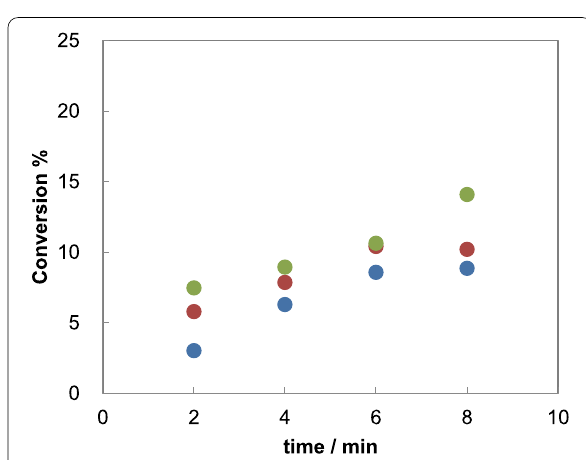
Fig. 6 EtOH conversion at different temperatures (without amine); ( ): 120 °C; ( ): 140 °C; ( ): 160 °C